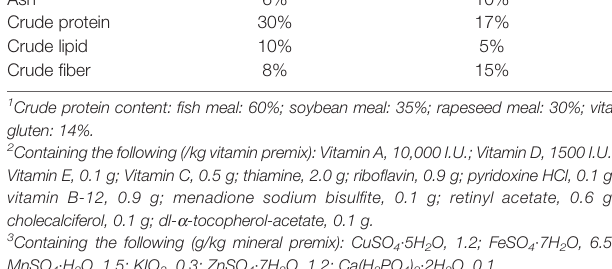
Diet in Experiment II (PBD I food)